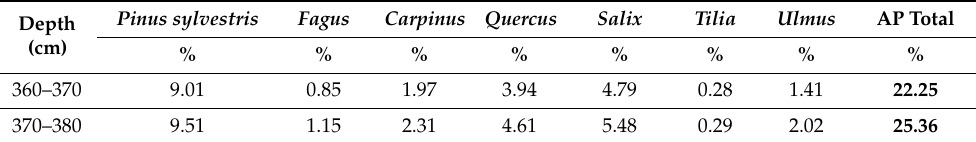
Table 1. Pollen composition and proportion of arboreal pollen (AP) material extracted from the samples of Cs á sz á rn é Mound.